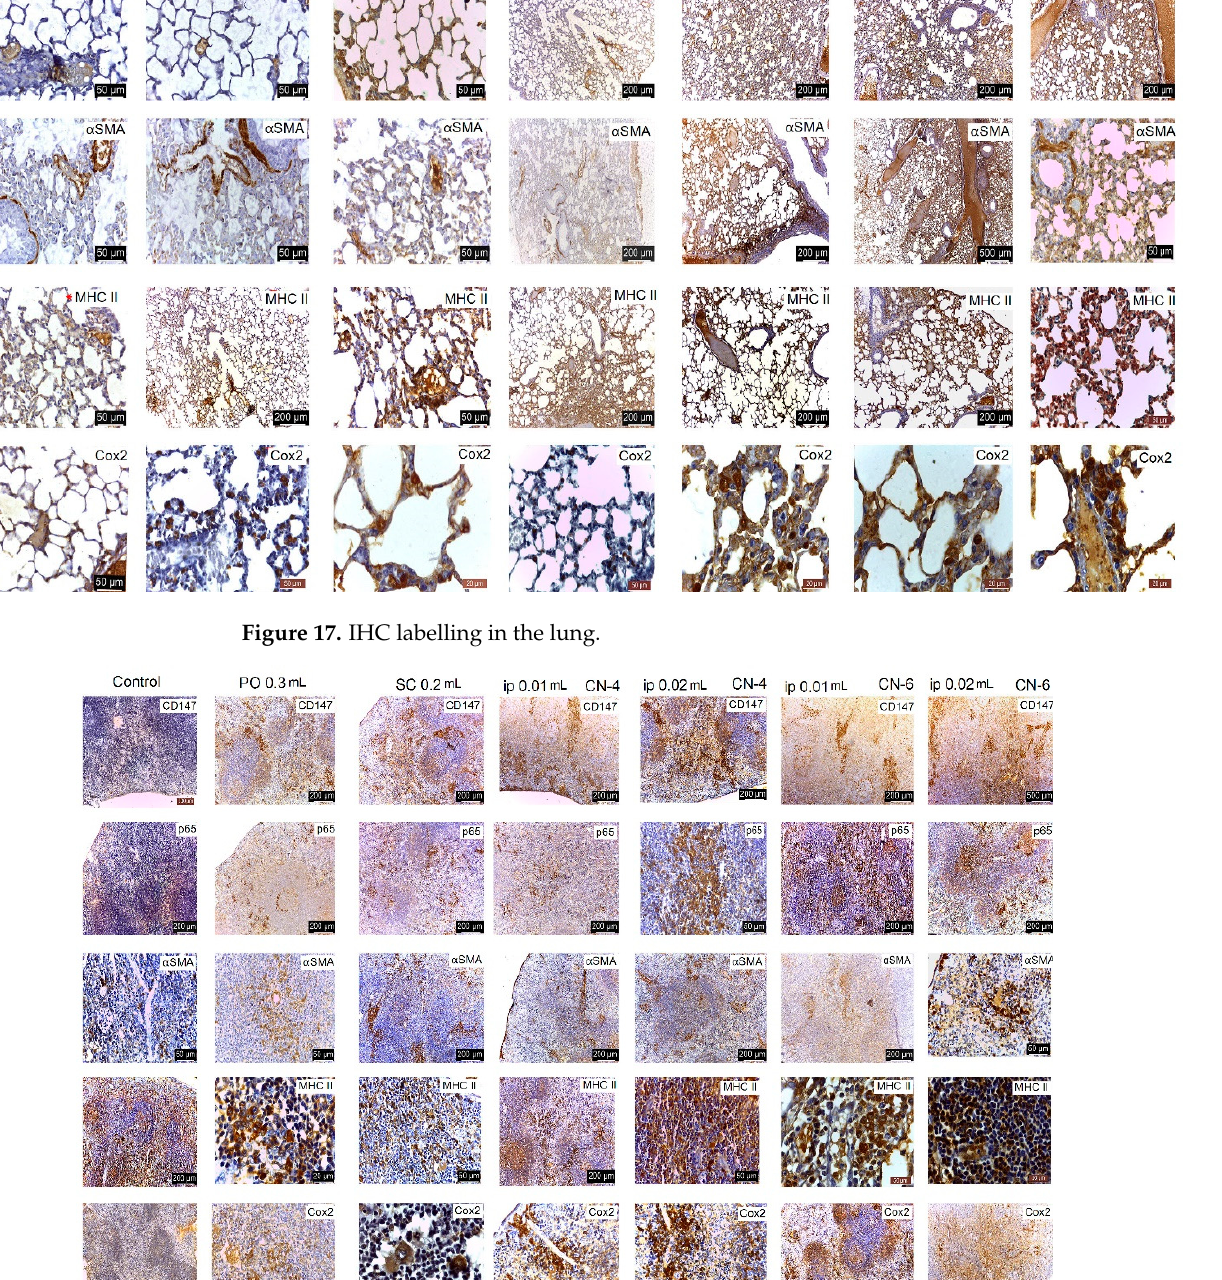
Figure 18. IHC labeling in the spleen. MHC-II antigens were expressed on some lymphocytes (LB); monocytic lineage cells; a small population of T helper cells; activated T cells; arteriolar, sinusoidal, and venous endothelium; Kupffer cells; spindle cells in the connective tissue of the portal tract;